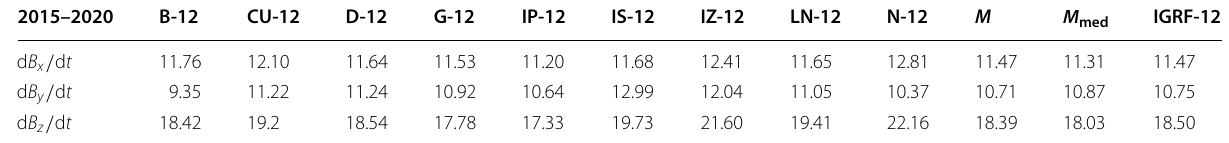
The lead institute letter codes are provided in Table 1. LN refers to LPG Nantes which was not a lead institute for